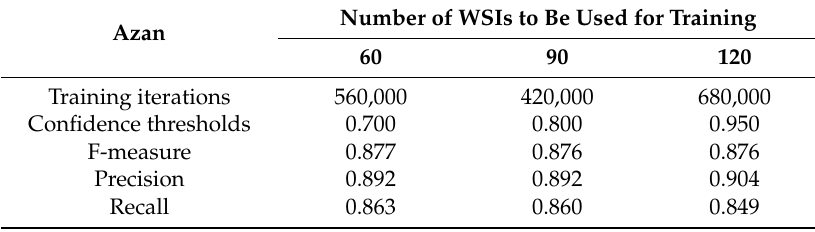
Table A4. Details of detection performance corresponding to the number of WSIs to be used for training the network